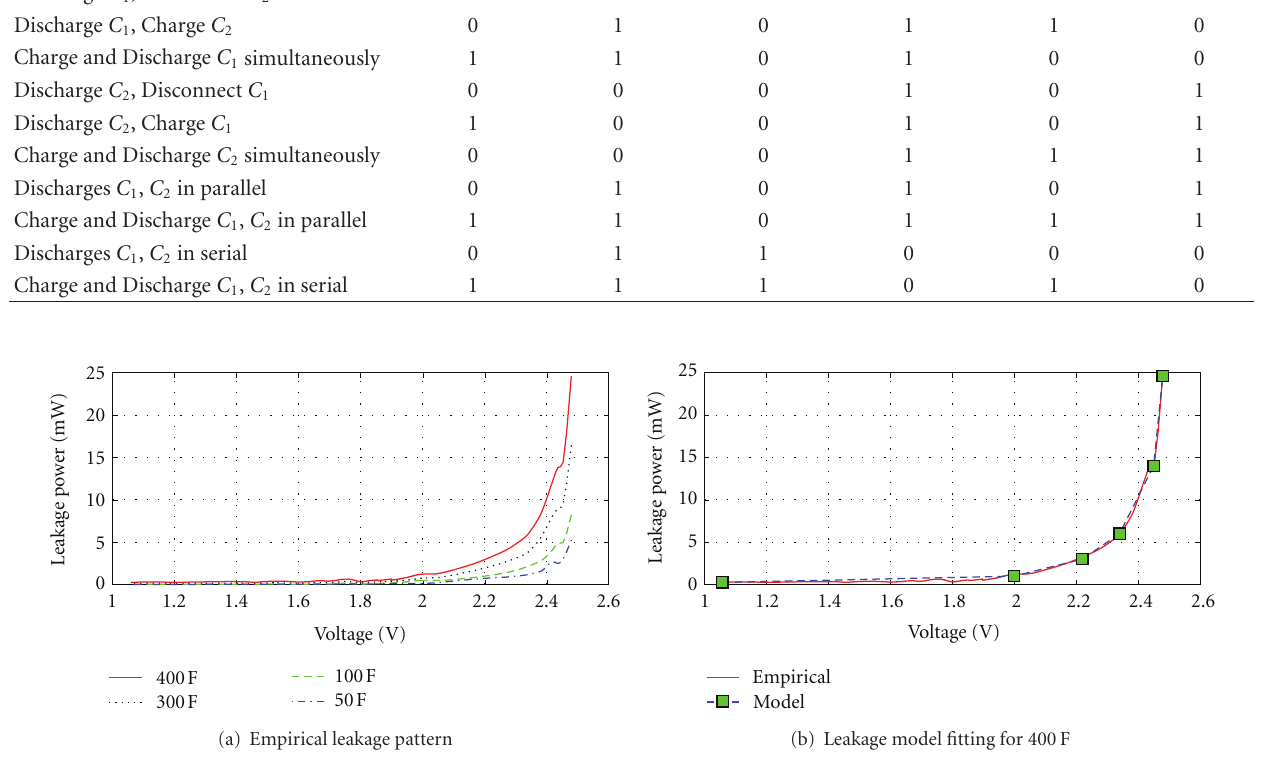
(b) Leakage model fitting for 400F